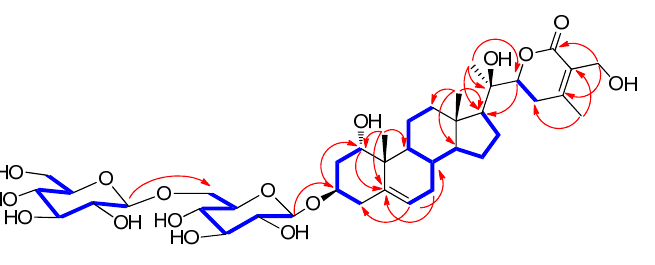
Figure 3. Chemical structures of compounds 1 – 5 .